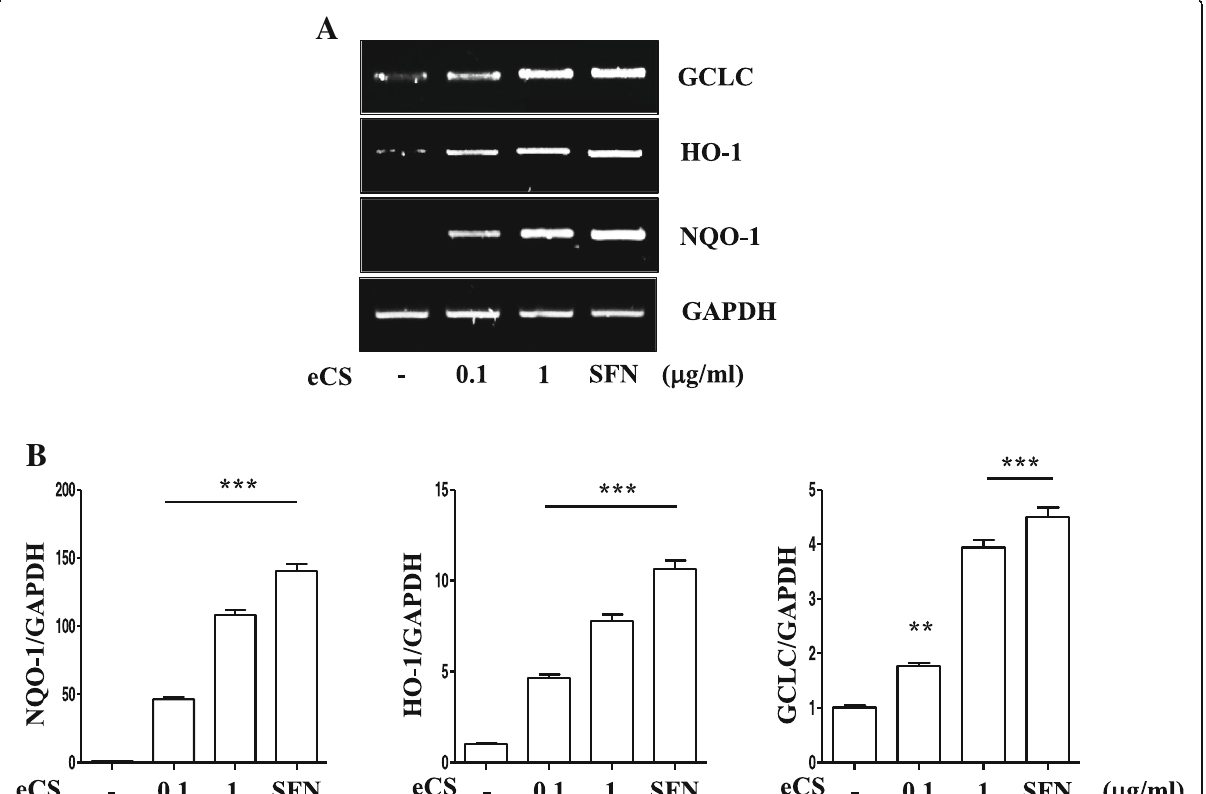
Fig. 5 The effect of eCS on the expression of Nrf2-dependent genes. a Total RNA was extracted from RAW 264.7 cells treated with eCS for 16 h, and expressions of GCLC, HO-1, and NQO-1 were analyzed by a semi-quantitative RT-PCR. The relative expression of Nrf2-dependent genes was calculated over GAPDH using ImageJ ( b ). ** P and *** P were less than 0.001 and 0.0001, respectively, compared to the untreated control. Data are presented as the mean ± SEM of 3 measurements, and a representative result of at least 3 independent experiments is